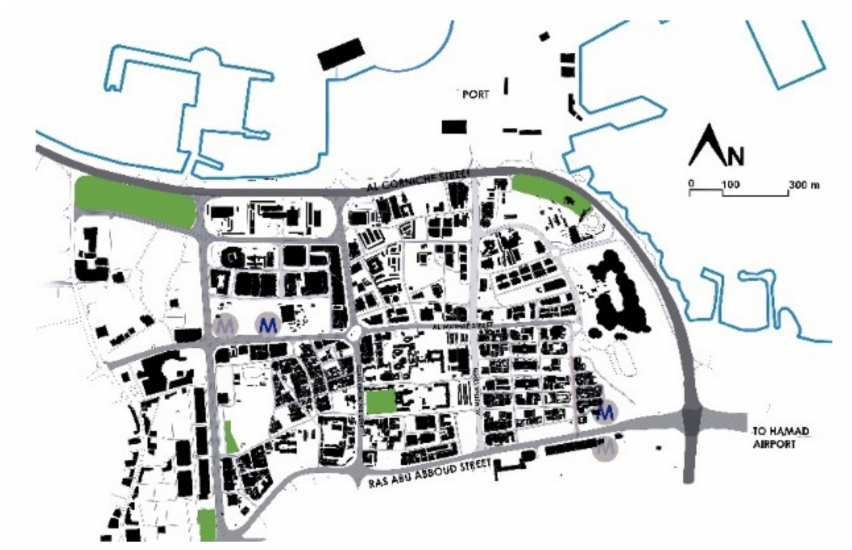
Figure 3. Figure ground map of the study area showing percentage area of different